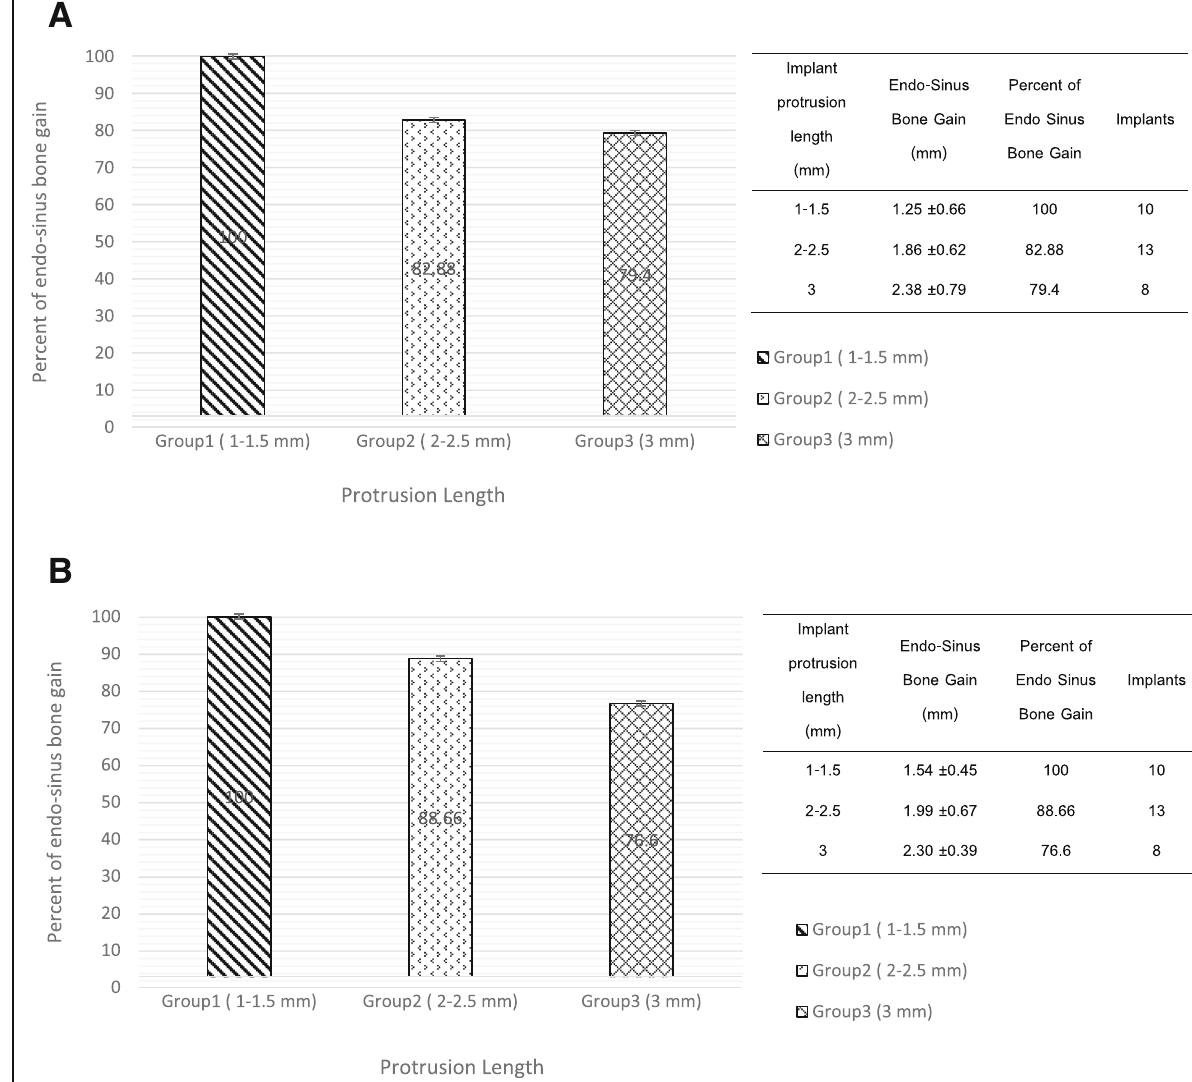
Fig. 3 The endo-sinus bone gain in relation to implant protrusion length in a the coronal view and b sagittal view